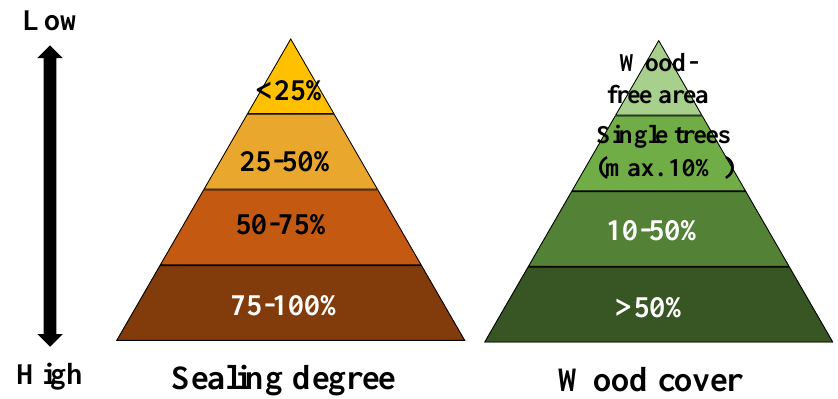
Figure 3. Steps of the sealing degree and wood cover according to the regional biotope and land use data set for built-up areas [35]. Table 2. Hemeroby degrees in the context of a built-up area (the urban degree names follow Schlüter 1999; LAU 1992 [34,35]). Built-up Area (According to the Regional Others Biotope and Land Use Data Set)